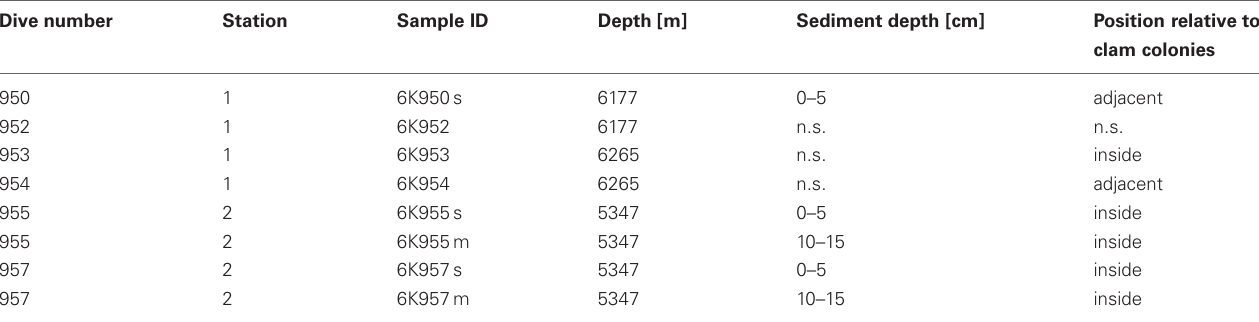
Table 1 | Samples used in this study: sampling station, water and sediment depth, and position relative to the Calyptogena colony (n.s.: not